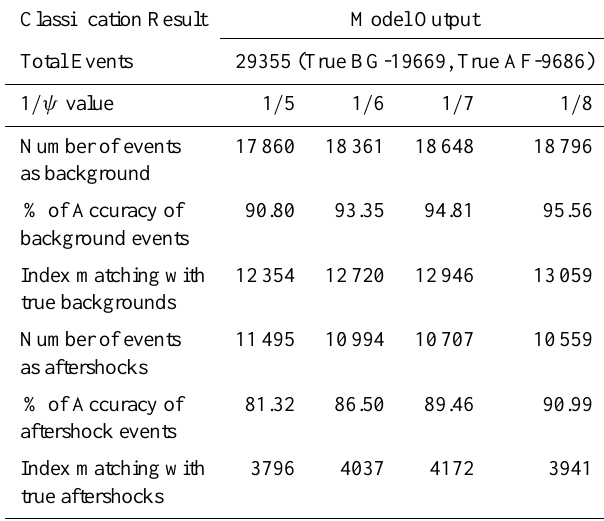
Table 2. Impact of different 1 /ψ value on model